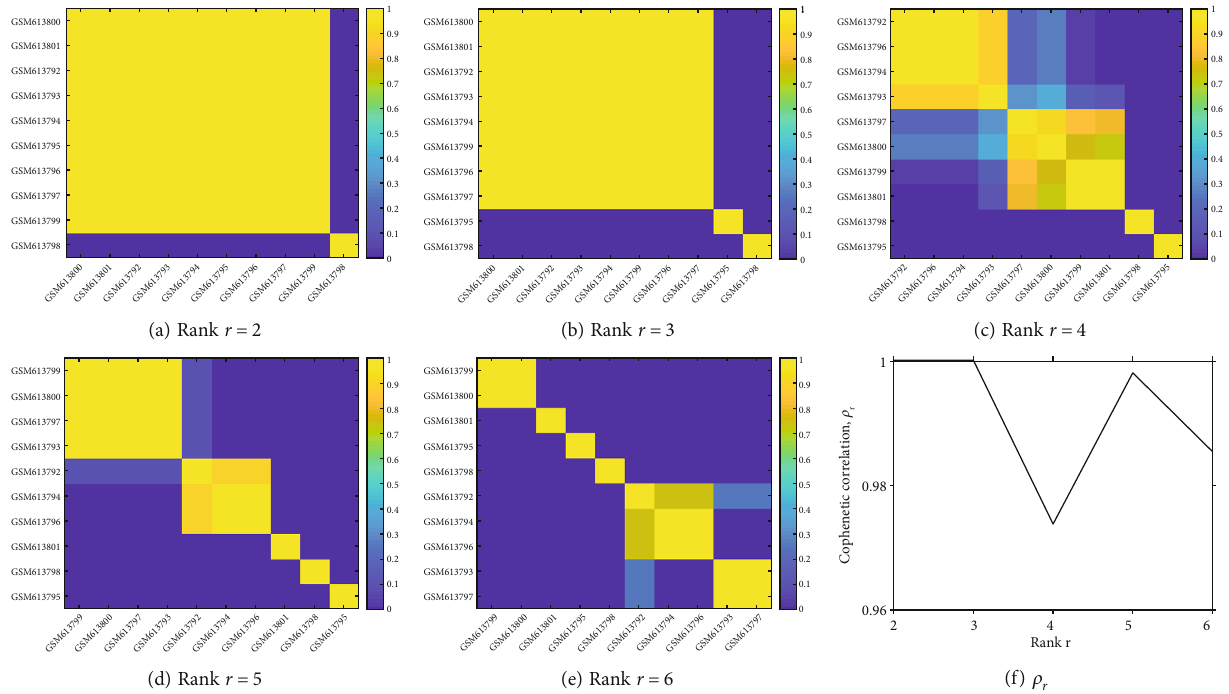
r = 2 ‐ 6 using r for